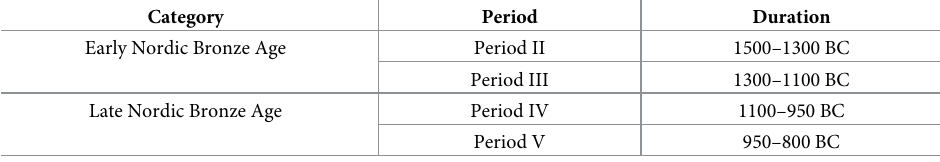
Table 1. Summary of chronological timespans associated with Periods II-V of the Nordic Bronze